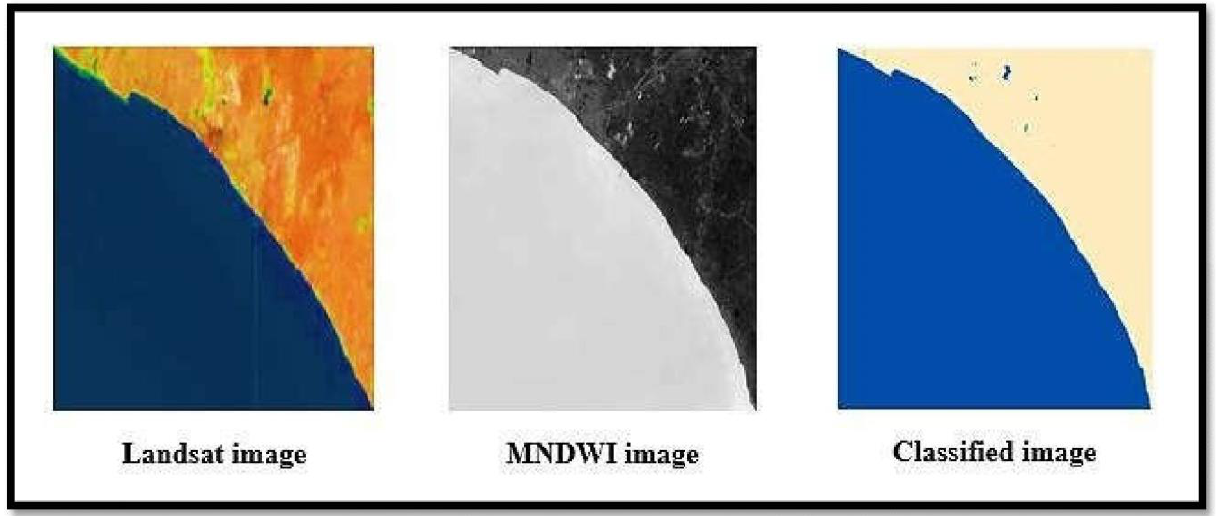
Figure 5. The classified image based on the MNDWI of the southern coast of Dakar.